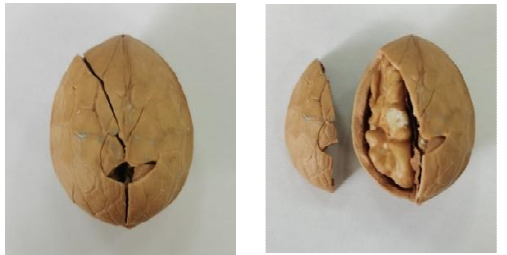
Figure 14. Walnut shell crack and complete kernel after shell-kernel